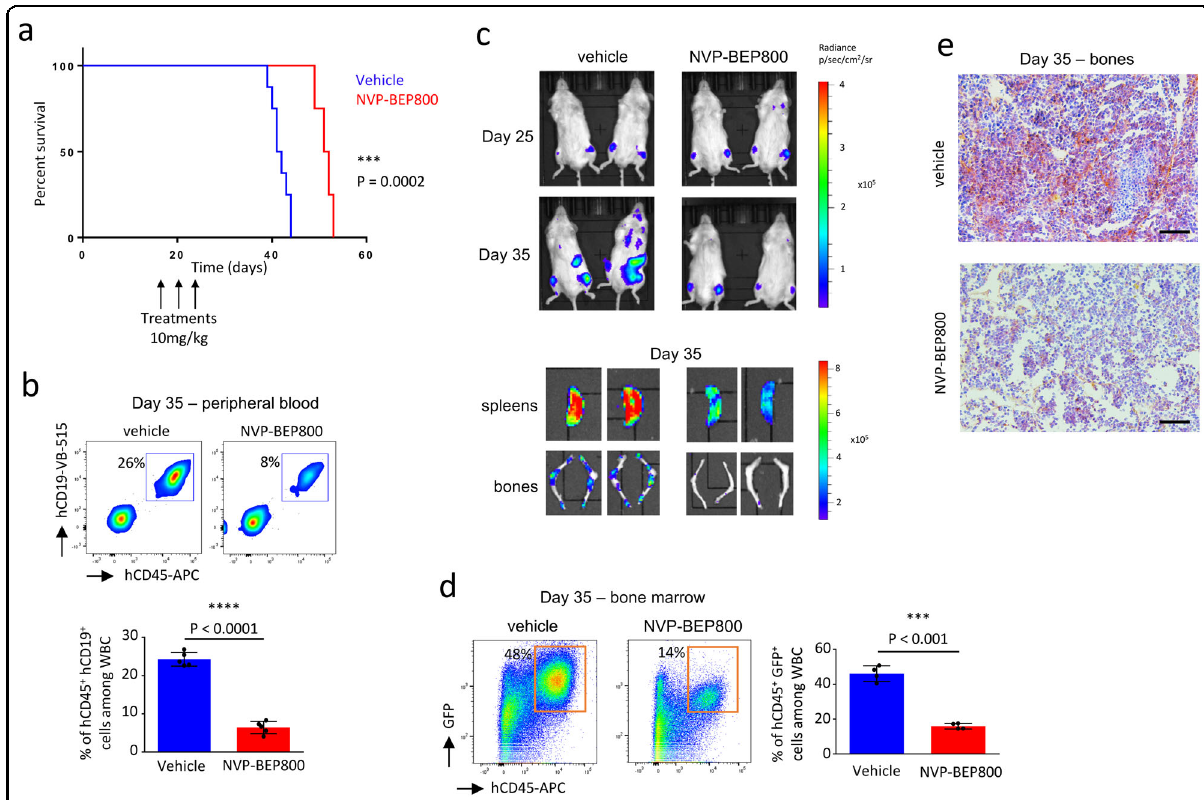
Fig. 8 Treatment with NVP-BEP800 improves survival of B-ALL PDX mice. a Survival curves show that mice treated with NVP-BEP800 (10 mg/kg) survived longer than mice treated with vehicle, n = 8 mice per group. P value measured by Mantel – Haenszel test; *** P < 0.001. The timing of treatment is shown on the graphic. b Percentage of B-ALL cells (hCD45 + hCD19 + ) is measured by fl ow cytometry in PB at day 35 of the study, n = 5 mice per group. Data are shown as mean ± SD. P -value measured by two-tailed unpaired Student ’ s t test; **** P < 0.0001. c Mice are transplanted with bioluminescent B-ALL cells and treated with NVP-BEP800. Bioluminescence images of two mice per group, are taken at days 25 and 35 post- transplantation of bioluminescent B-ALL cells. At day 35, mice are sacri fi ced and bioluminescence images of their spleens and bones are taken. d Data show a reduction of B-ALL cells in BM of treated mice, as analyzed by fl ow cytometry to detect bioluminescent leukemic cells also expressing GFP and stained with hCD45 antibody. Data are shown as mean ± SD; n = 4 mice. P -value measured by two-tailed unpaired Student ’ s t test; *** P < 0.001. e Immunohistochemistry on bones sections shows a decrease in the amount of B-ALL cells (brown cells) in mice treated with NVP-BEP800. Counterstaining with Giemsa. Data is representative of four mice, magni fi cation ×20, black scale bars represent 100